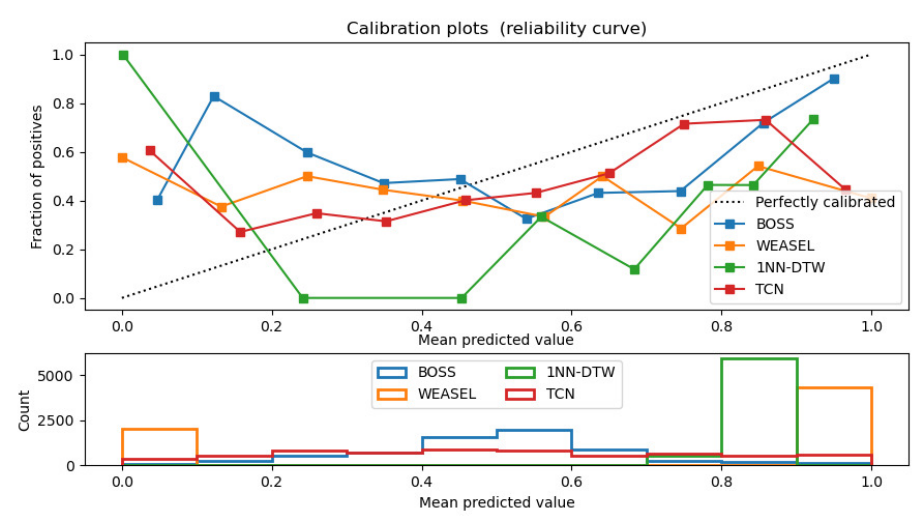
Figure 12. models calibration comparisons among 1DNN-DTW, BOSS, WEASEL and